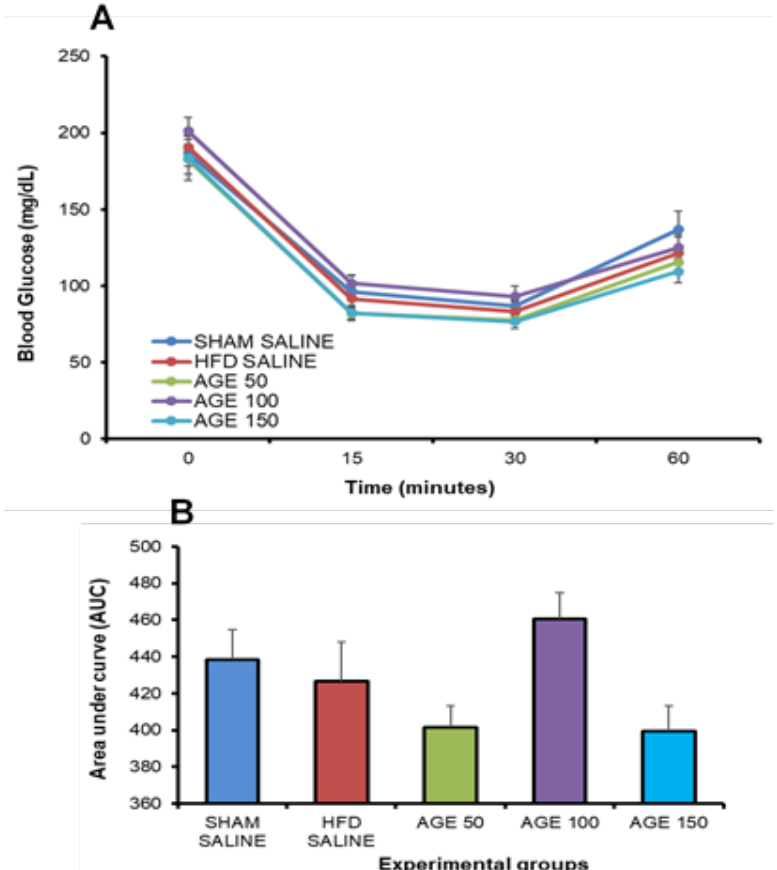
Figure 4. Evaluation of the glycemic profile at the end of the treatment with AGE. ( A ) Insulin sensitivity test performed at the end of treatment. ( B ) Area under the curve (AUC) of the insulin sensitivity test at the end of treatment. SHAM SALINE: standard diet + saline solution. HFD SALINE: hyperlipidic diet + saline solution. AGE 50: hyperlipidic diet + 50 mg / kg of aqueous graviola leaf extract. AGE 100: hyperlipidic diet + 100 mg / kg of aqueous graviola leaf extract. AGE 150: hyperlipidic diet + 150 mg / kg of aqueous graviola leaf extract. Each column represents the mean, and the bar represents the mean standard error.